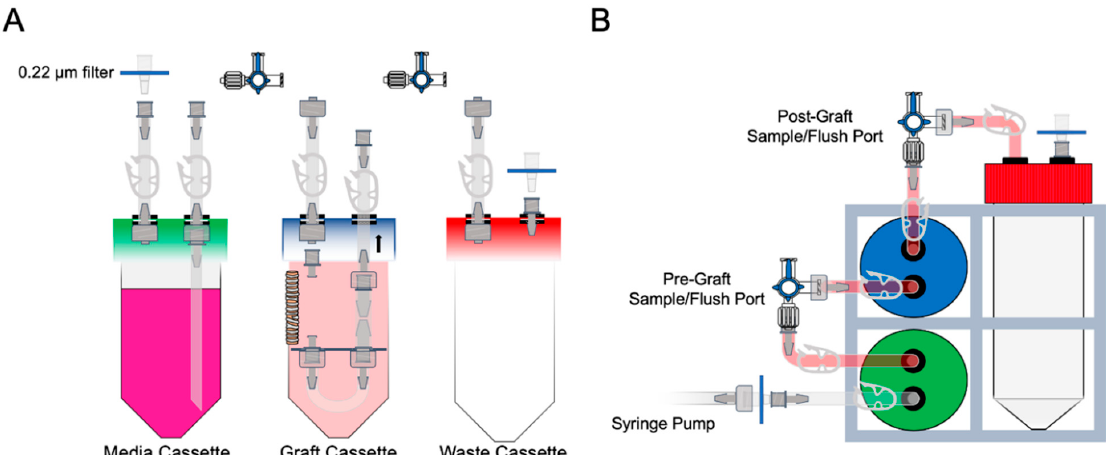
Figure 2. Recellularization. ( A ) Two cassettes, in addition to the bioreactor, were used for the recellularization process: a media cassette and a waste cassette. ( B ) The media cassette was submerged into expansion media, as described, and the waste cassette was fitted onto an empty conical tube. A syringe pump was attached to the 0.22 ‐μ m filter and pneumatically forced the media through the tubing at a rate of 0.5 mL/h.